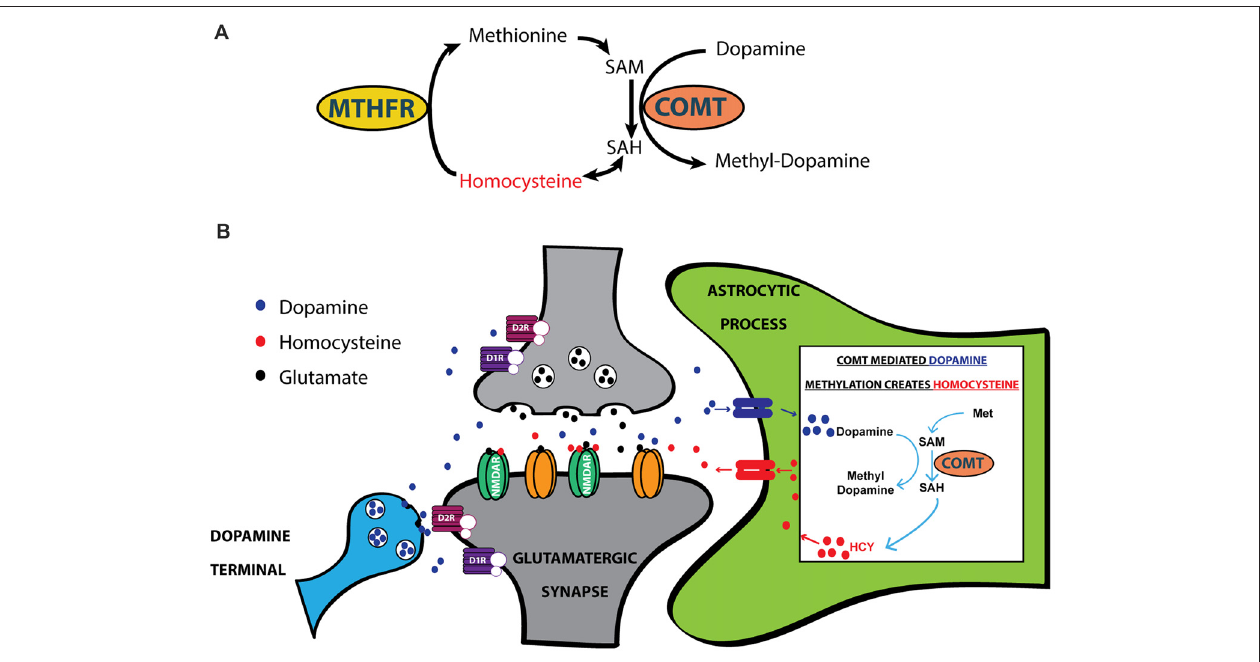
FIGURE 3 | HCY arises after dopamine breakdown by Catechol-O-Methyltransferase (COMT). (A) HCY is generated when COMT methylates catecholamine neurotransmitters, including dopamine, to initiate the breakdown process. Free HCY is then remethylated for future catecholamine methylations via a folate-dependent process. The folate derivatives required for HCY methylation are produced by the enzyme Methyl-Tetrahydrofolate Reductase (MTHFR). (B) The production of HCY has been shown to occur after dopamine methylation in astrocytes (Huang et al., 2005). Astrocytes then release HCY to the extracellular space, where free HCY can interact with receptors on glutamatergic synapses. SAM, S-adenosyl-methionine; SAH,